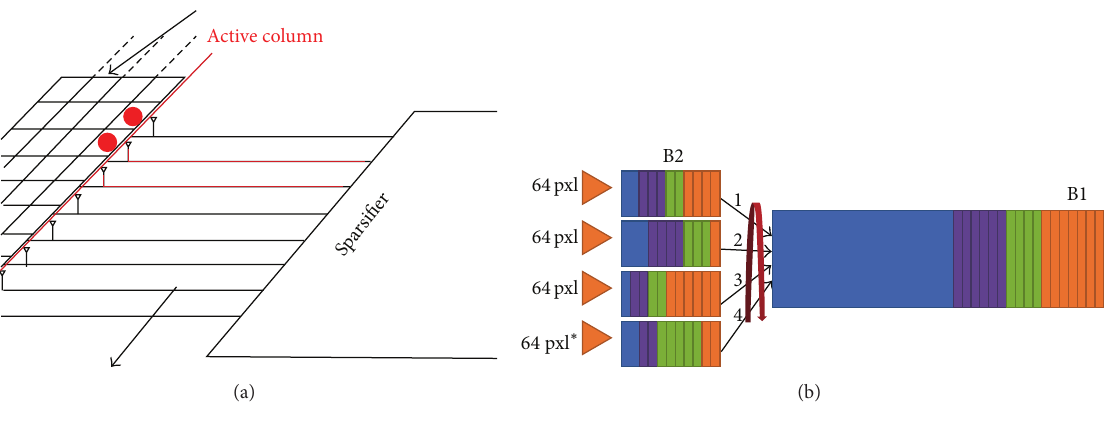
Figure 19: Sparsified data and barrel